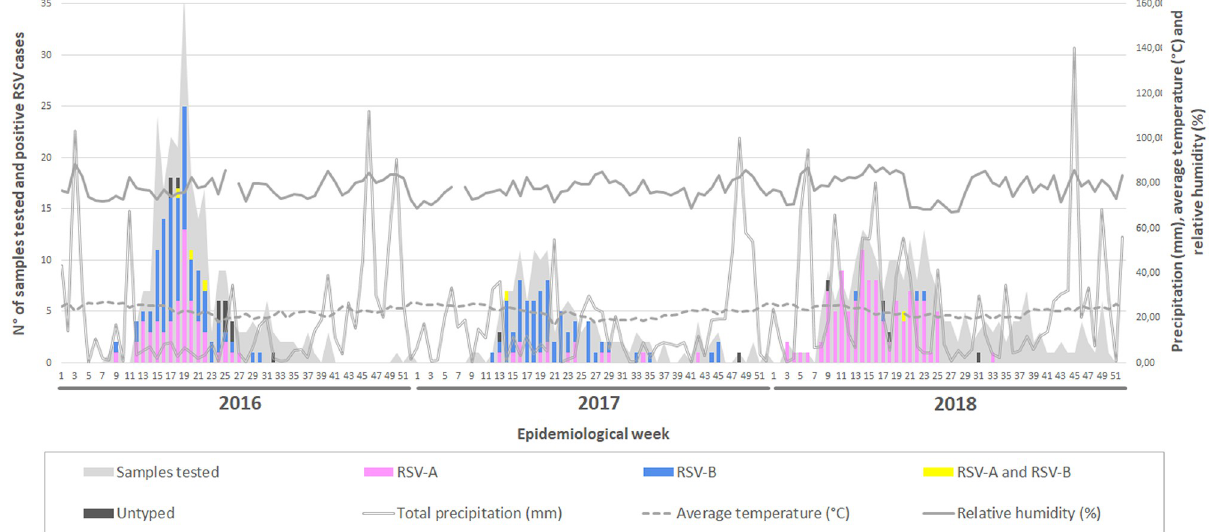
Fig 1. Circulation of RSV-A and RSV-B between 2016 and 2018 in Espirito Santo State. The X-axis shows the epidemiological weeks (EW) for each year. The primary Y-axis displays the number of positive cases for each of the subtypes and the secondary Y-axis shows the values of the climatic variables. The gray zone indicates the total number of samples tested in each